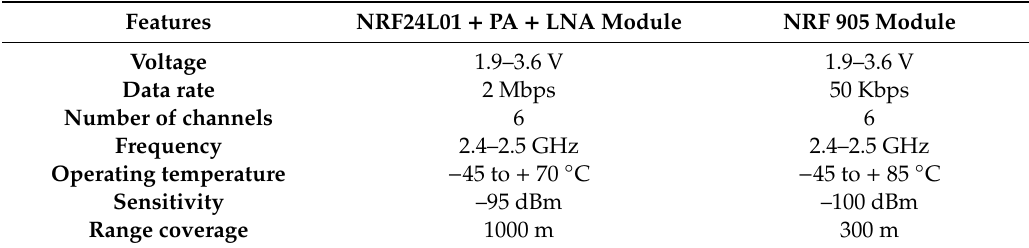
Table 1. Radio frequency module comparison.